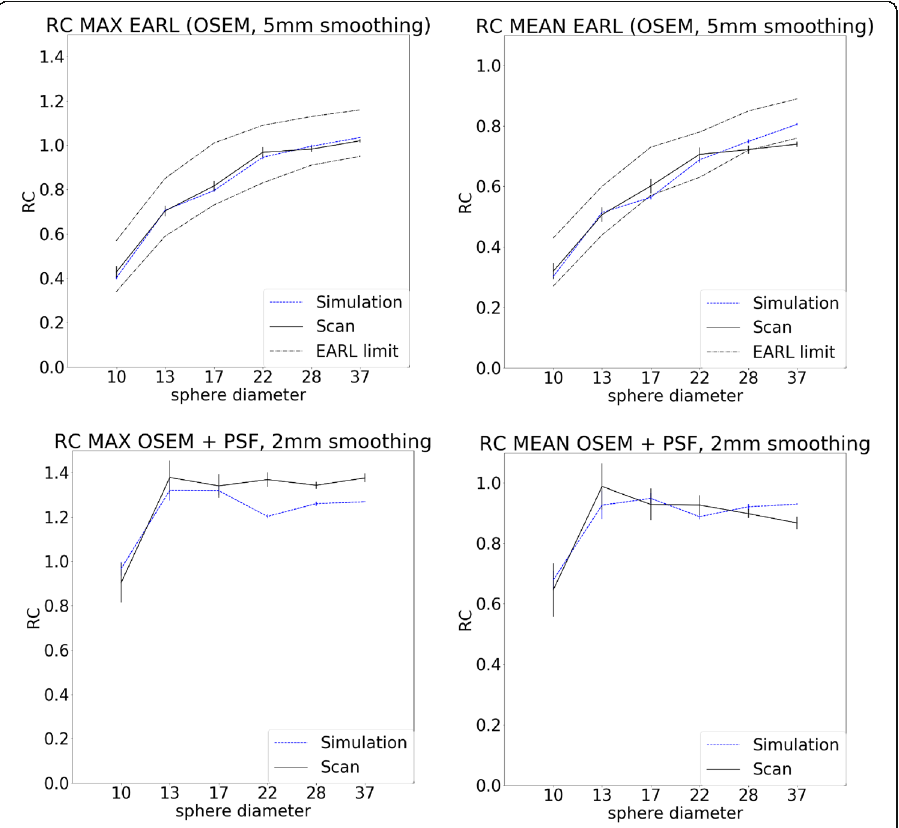
Fig. 6 RC max (upper line) and RC mean (lower line) and the standard deviation of the RC values as function of sphere sizes for EARL reconstruction (OSEM + 5 mm smoothing) on the left and OSEM+PSF reconstruction with 2 mm smoothing on the